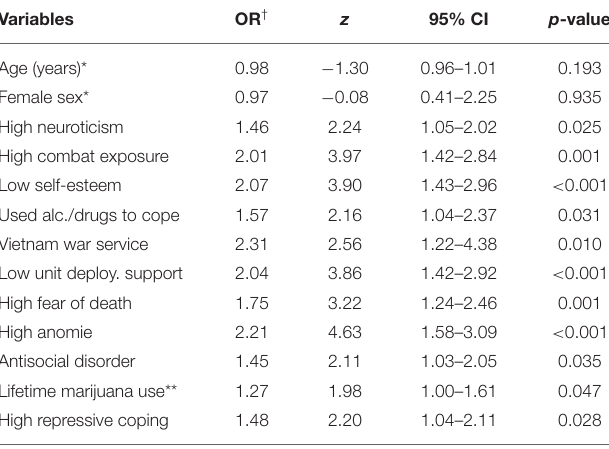
TABLE 2 | Stepwise multivariable logistic regression predicting high vs. low MI score ( N = 1,029) ‡ .